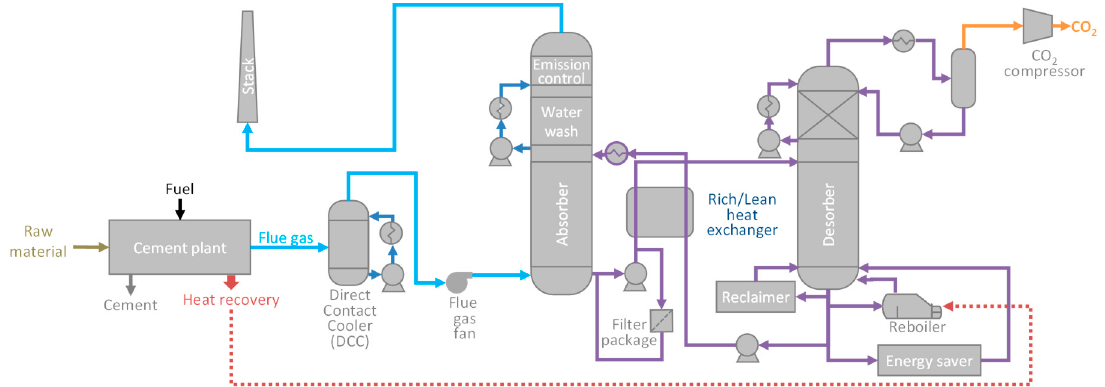
Figure 5. Generic flow sheet of an ACC TM process integrated in a cement plant.